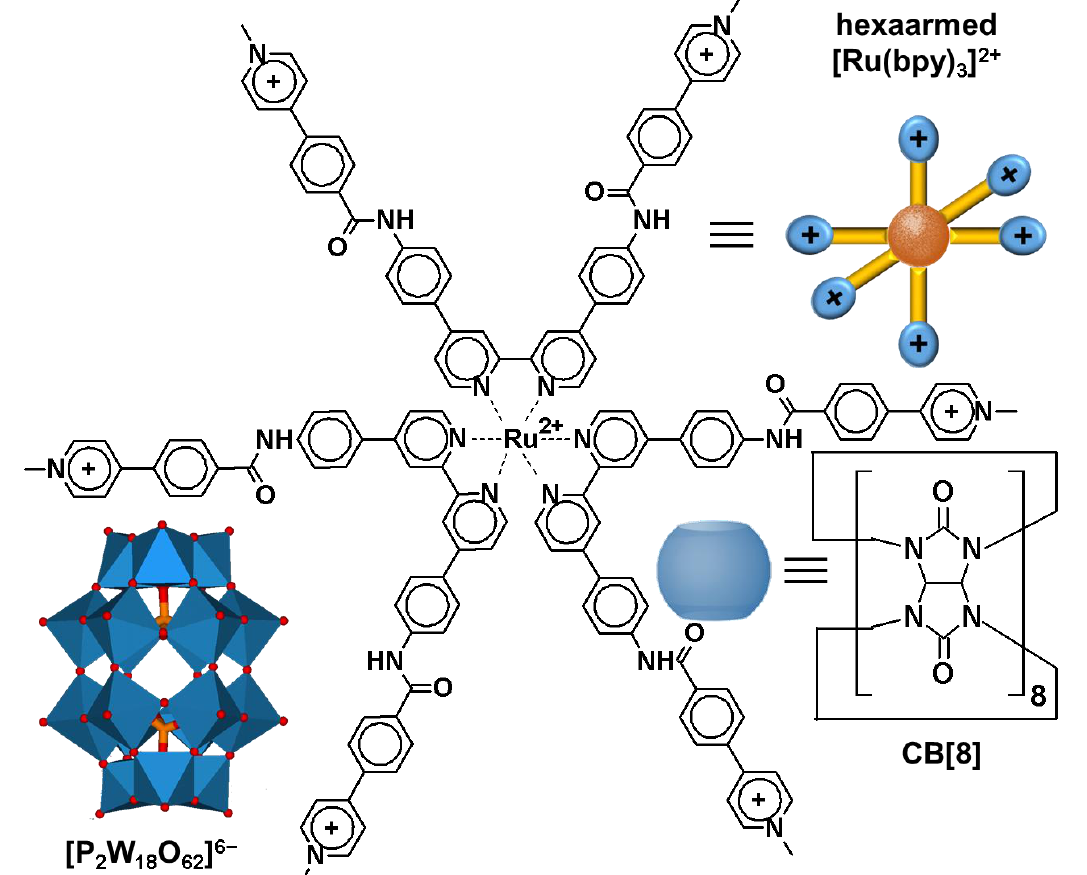
Figure 51. The structure of hexaarmed [Ru(bpy )3 ] 2+ , CB[8], and a redox-active [P 2 W 18 O 62 ] 6− unit.